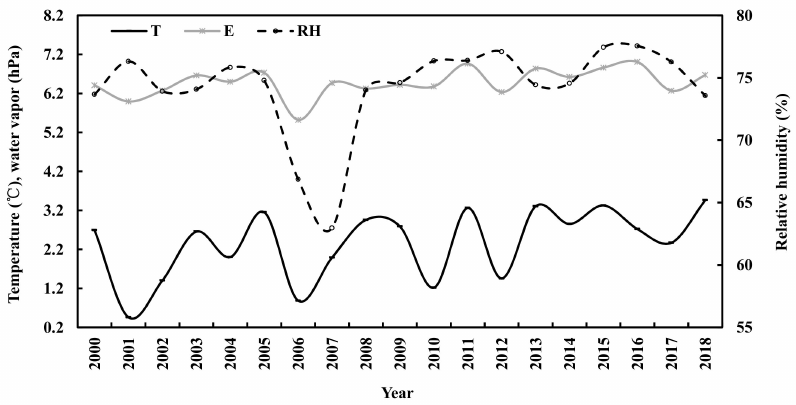
Figure 7. Annual air temperature (T), relative humidity (RH) and water vapor pressure (E) at